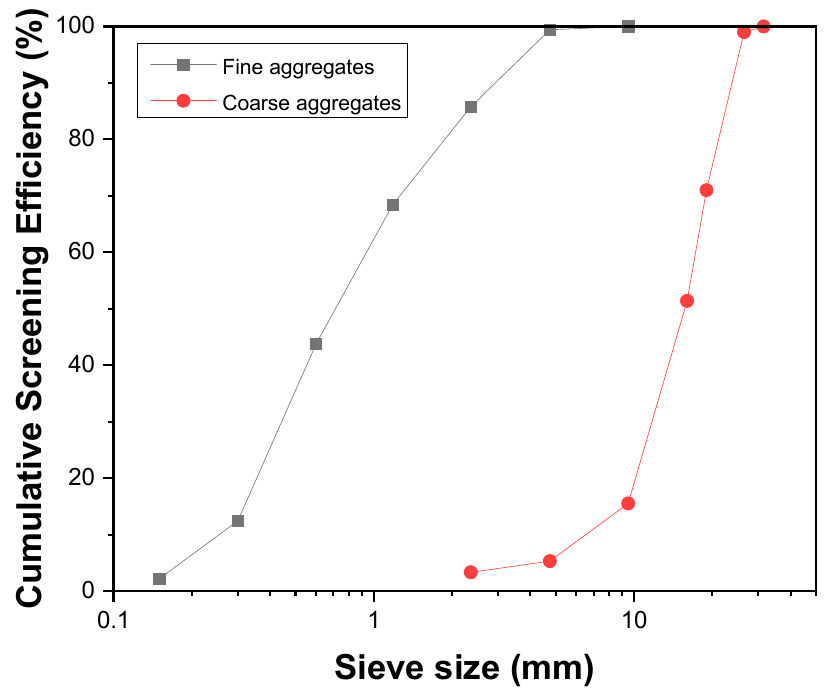
Figure 1. The grading curves of fine aggregates and coarse aggregates. Table 2. Mix formulation to prepare CSA and OPC concretes (Unit: kg/m 3 ).